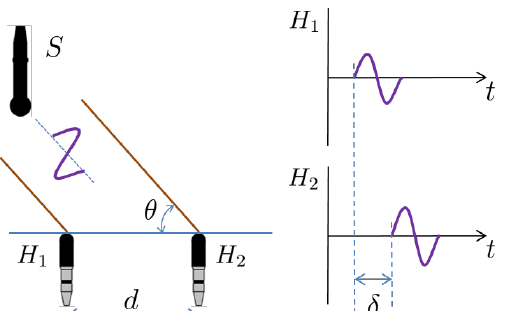
Figure 1. Directional angle estimation of underwater acoustic source using TDOA. Assuming that the source ( S ) is located a large distance from the receivers ( H 1 and H 2 ), the plane wave arrives at the receivers at measurably different